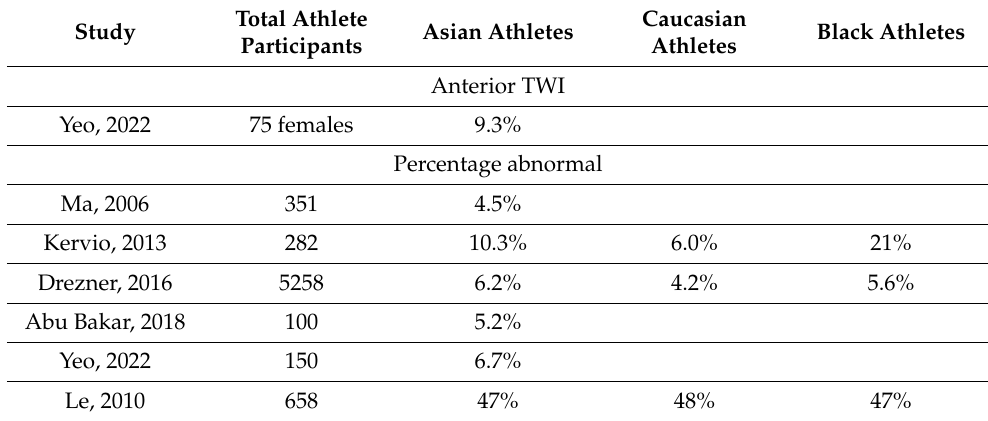
Table 7. Proportions of ECG changes in Asian athletes compared to others.